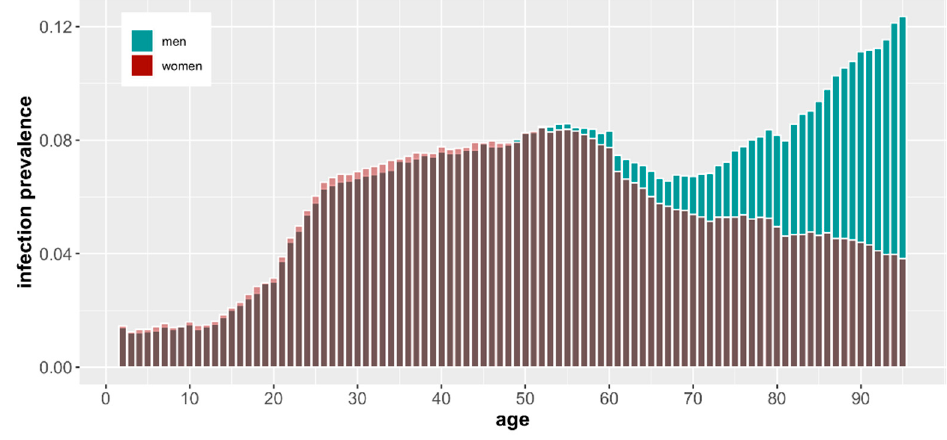
Figure 3. COVID-19 infection rate as a percentage of the population by age and sex based on demographic data from December 2019.